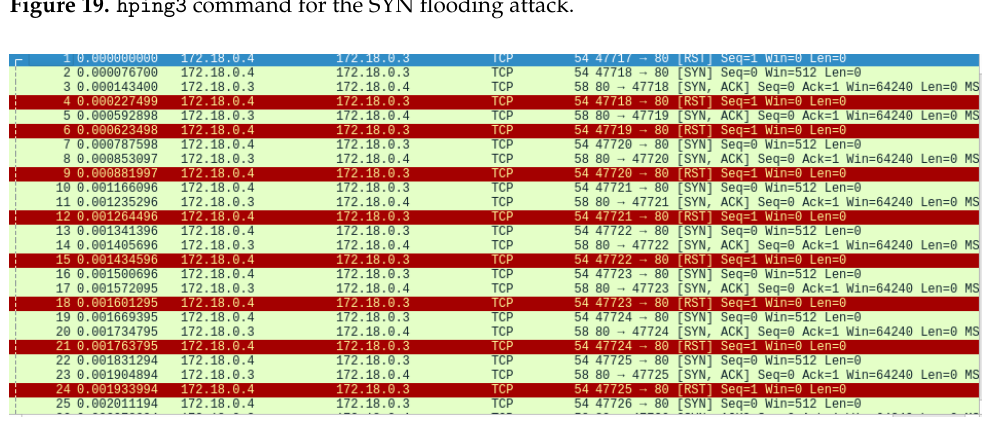
Figure 19. hping3 command for the SYN flooding attack.